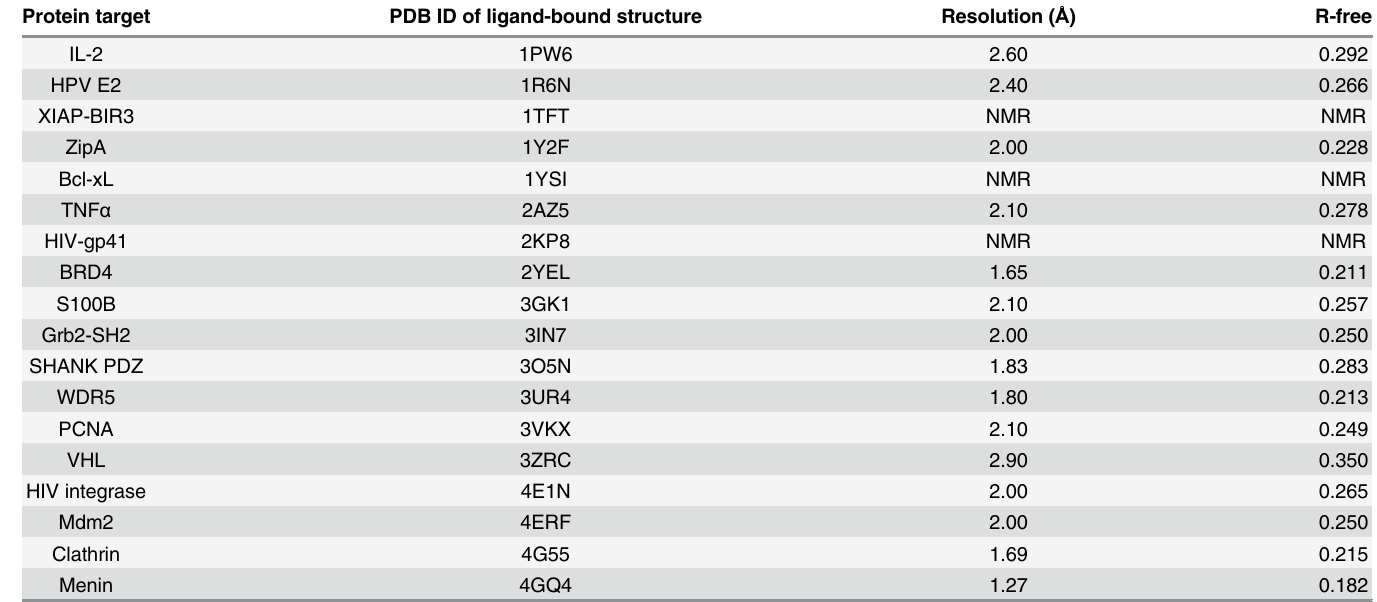
Table 1. Protein targets used in this study. These targets correspond to non-redundant protein-protein interaction sites for which a crystal structure or an NMR structure has been solved in complex with a small-molecule inhibitor. For this study, three protein targets have been removed from our previously reported set [29] (see